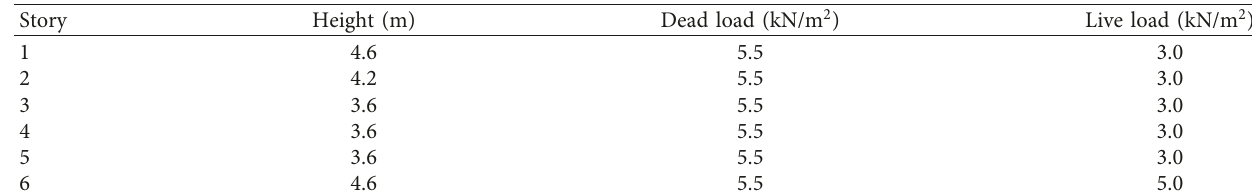
Table 4: Story heights and